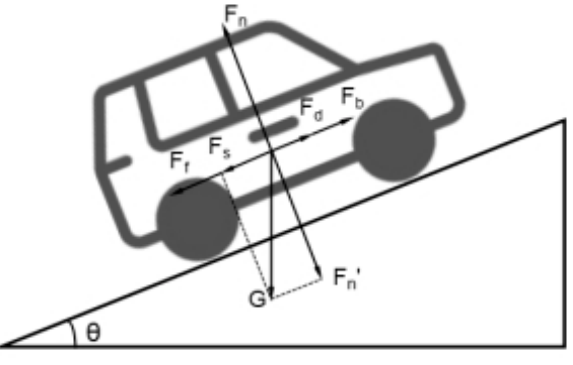
Figure 2. Force Diagram of Vehicle Climbing.